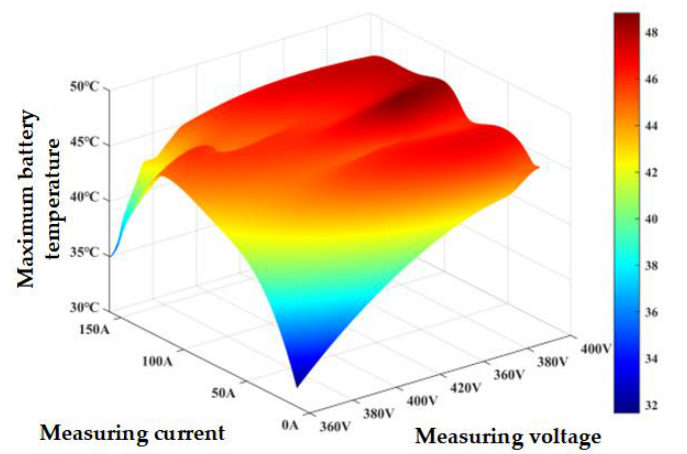
Figure 16. Three-dimensional graph of the maximum battery temperature, measured current, and measured voltage data during the charging process of lithium iron phosphate battery.